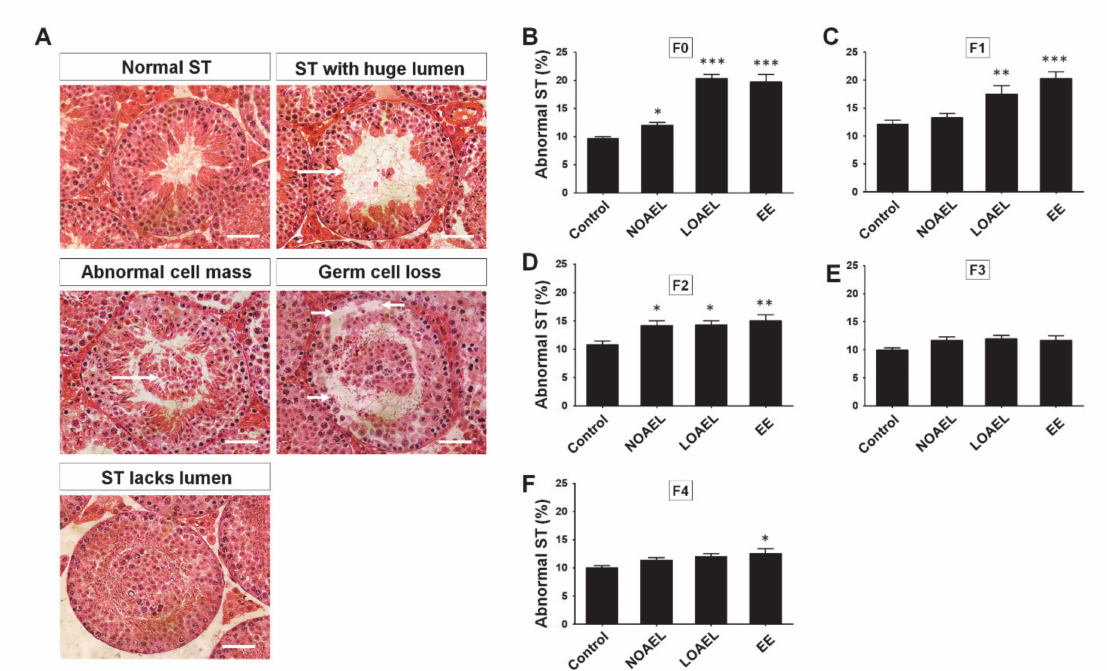
Figure 2. Testicular cross section and abnormal seminiferous tubules (STs) due to bisphenol-A (BPA) exposure. ( A ) Hematoxylin and eosin-stained testicular cross sections in the control, BPA doses [no-observed-adverse-e ff ect-level (NOAEL), lowest-observed-adverse-e ff ect level (LOAEL)], and ethinylestradiol (EE). It was showing normal STs along with abnormal STs, characterized as STs with a large lumen, abnormal cell mass, loss of germ cells, and that lack lumen. Arrows in the images indicate the positions of abnormality. Scale bar = 50 µ m. Percentages of abnormal tubules are presented as bar graphs; ( B ) exposed group (F0) ( n = 14 mice / group), ( C ) F1 generation ( n = 15 mice / group), ( D ) F2 generation ( n = 12 mice / group), ( E ) F3 generation ( n = 12 mice / group), and ( F ) F4 generation ( n = 19 mice / group). Data were analyzed by one-way analysis of variance (ANOVA) where the asterisk (*) indicates significant di ff erences compared with the control ( * p < 0.05, ** p < 0.01 , and *** p < 0.001